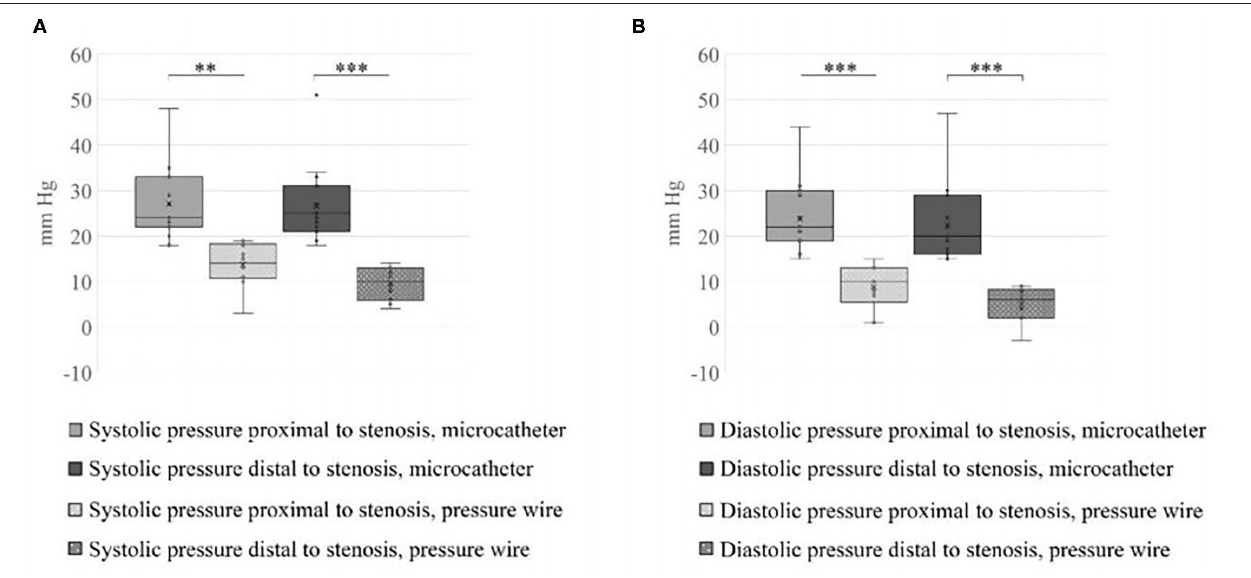
FIGURE 4 | Systolic and diastolic values measured proximal and distal to the stent. (A) SVP and (B) DVP across the treated stenosis obtained by the two measurements systems. The blood pressure range measured by the two methods, for all the cases tested, differ significantly (** p < 0.01, *** p <